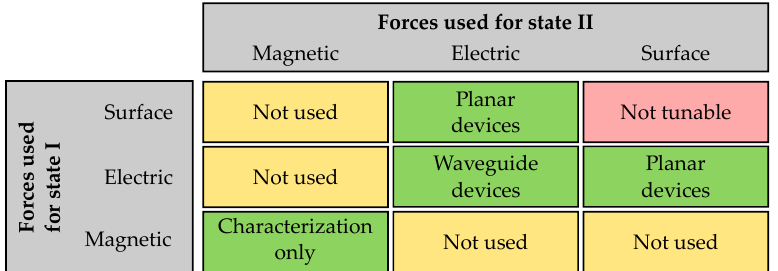
Table 1. Summary of combination of different alignment mechanism and their application to tunable microwave devices. Note that the numbering of the states has been arbitrarily chosen. “ Not tunable ” denotes combinations where electrical tuning cannot be achieved. E.g., a surface-surface combination will result in a static configuration. “ Not used ” denotes combinations, which can be used in principle but are not used in practice.